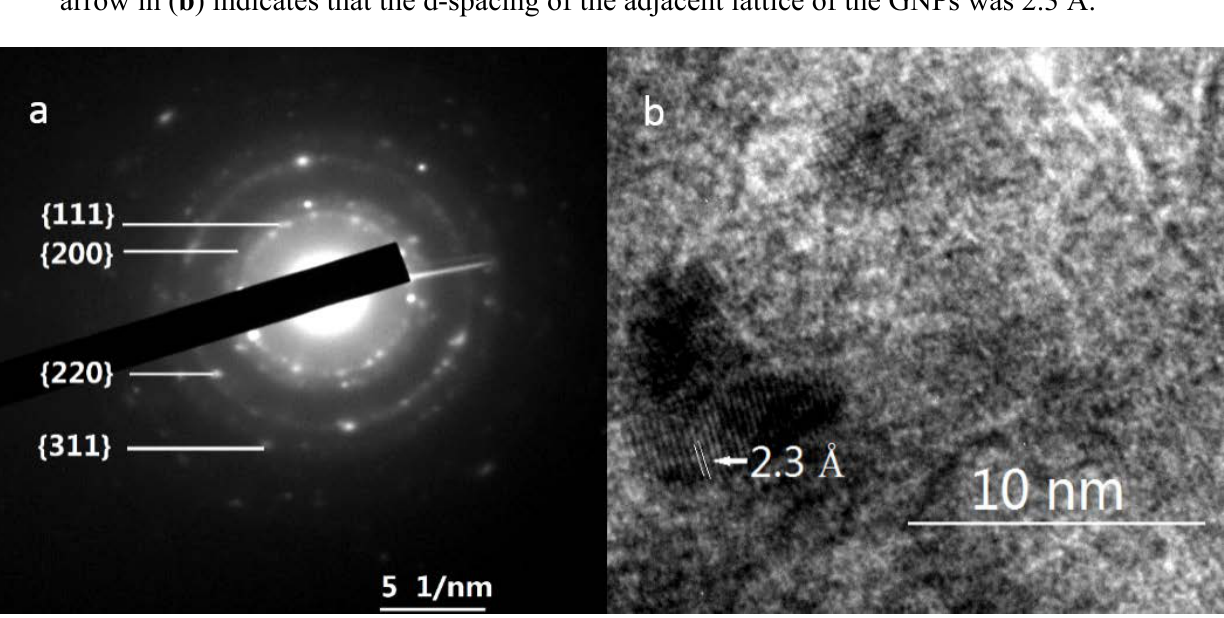
Figure 4. Representative TEM image of single Au nanoparticles ( a ) and their electron diffraction pattern ( b ). The diffraction spots of Rings 1, 2, 3 and 4 are due to the (111), (200), (220) and (311) reflections of the lattice planes of the facing center cube. The white arrow in ( b ) indicates that the d-spacing of the adjacent lattice of the GNPs was 2.3 Å.